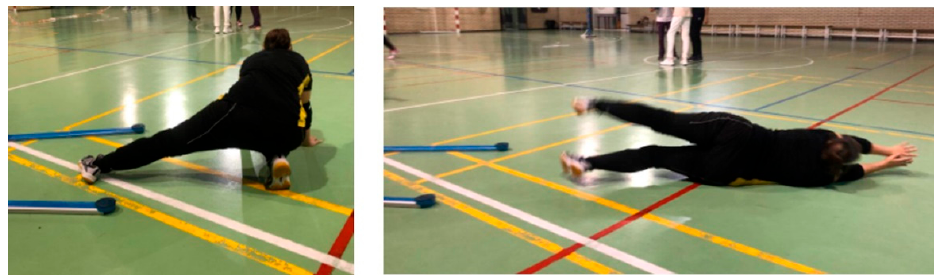
Figure 3. Specific defensive goalball movement from low position with the acoustic stimulus.